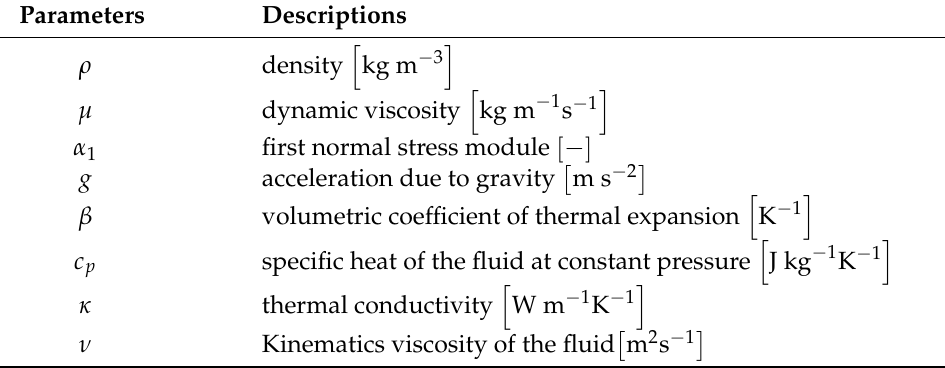
Table 1. Parameter descriptions. Parameters